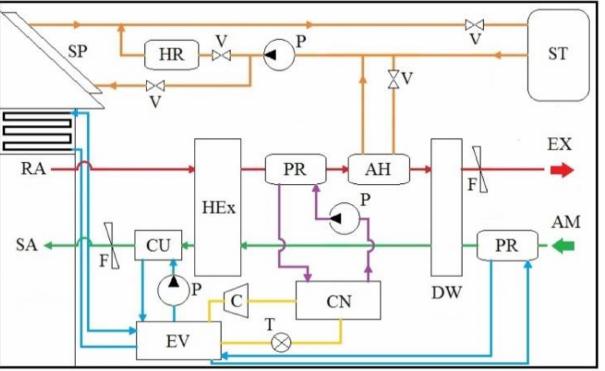
Figure 13. Schematic of Solar desiccant cooling system with radiant